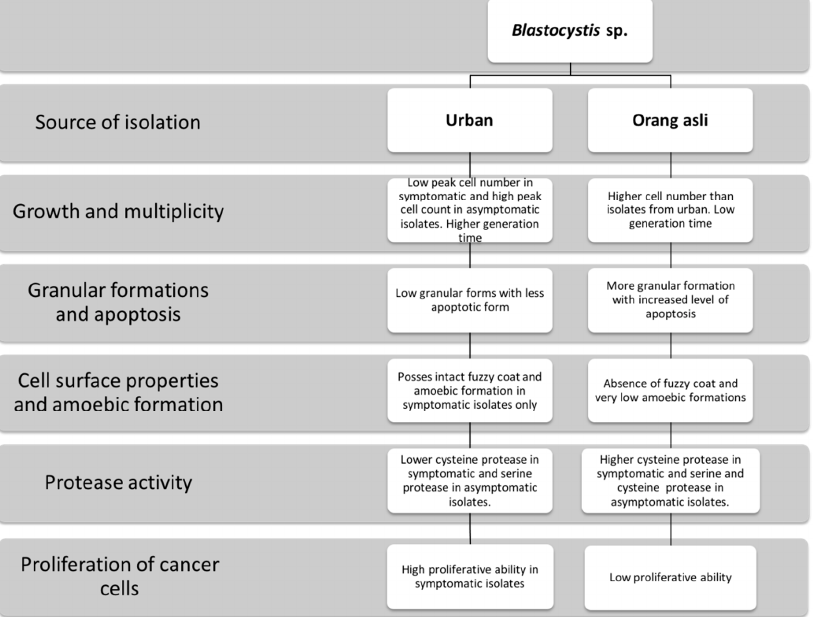
Figure 8. Schematic diagram explaining the phenotypic and potential pathogenic differences be- tween Blastocystis sp. isolated from urban and orang asli individuals. These groups have distinct gut microbial profile. It is clear that gut environment plays a pivotal role in altering the phenotype of Blastocystis sp. and its pathogenic potentials. Supplementary Materials: The following are available online at www.mdpi.com/xxx/s1, Figure S1: Phylogenetic tree analyzing the urban and orang asli isolates of Blastocystis sp. ST3 inferred using the Neighbor-Joining